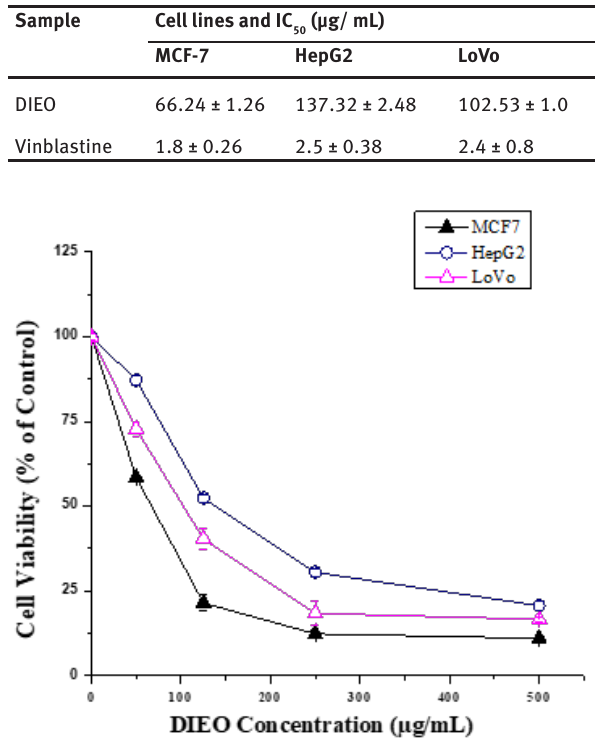
Table 2: Cytotoxic activity of D. ismaelis essential oil against different cancer cells.